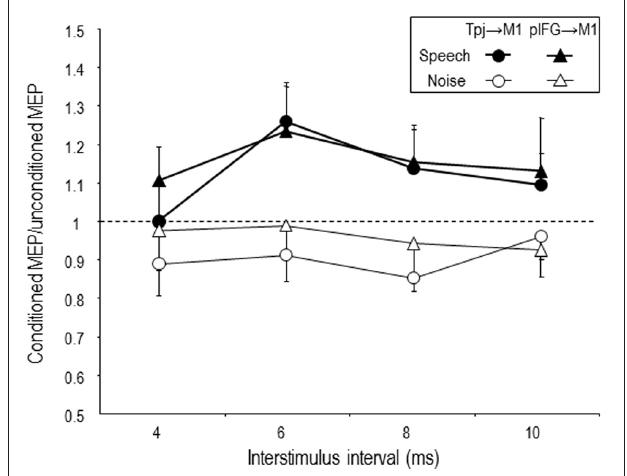
FIGURE 1 | Mean task-dependent Tpj → M1 (circle) and pIFG → M1 (triangle) effective connectivity during listening to speech (filled symbols) or to white noise (control condition, open symbols). Effective connectivity was studied at four interstimulus intervals between the conditioning pulse (Tpj or pIFG) and the test pulse (M1 representing to lip area). Both Tpj → M1 and pIFG → M1 effective connectivity increased during listening to speech when compared to listening to white noise. At the interstimulus interval of 6ms, the most prominent facilitation of the effective connectivity was observed. Error bars are SEM. Figure is reproduced, with permission from Murakami et al. (2012),